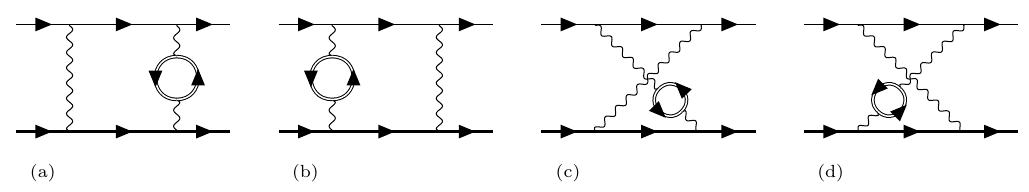
Figure 6. NNLO Box diagrams. Direct diagrams (a)–(b) and crossed diagrams (c)–(d).